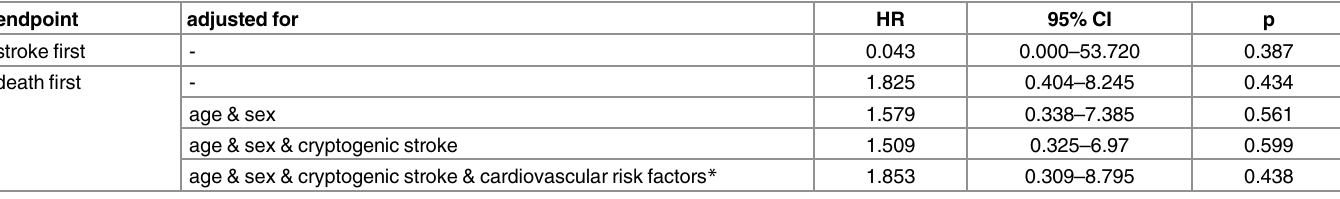
Table 5. Multivariate analysis for young patients.